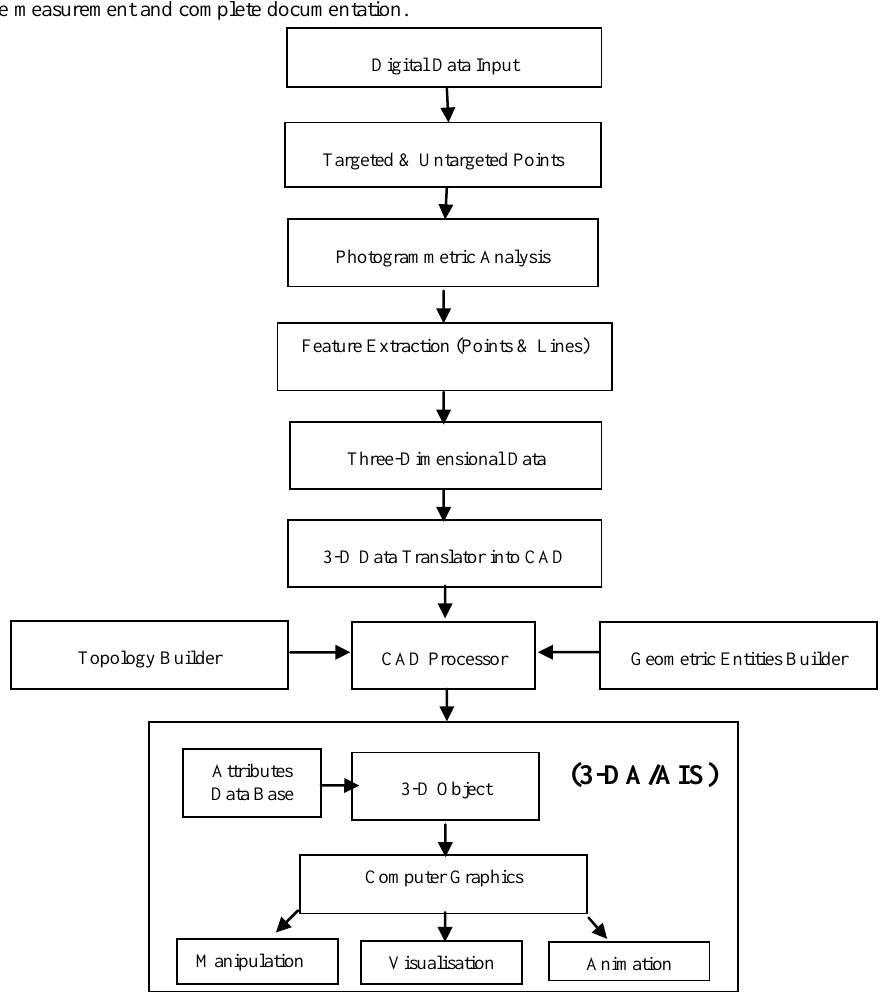
Figure 3: Overview of Architectural and Archaeological Information